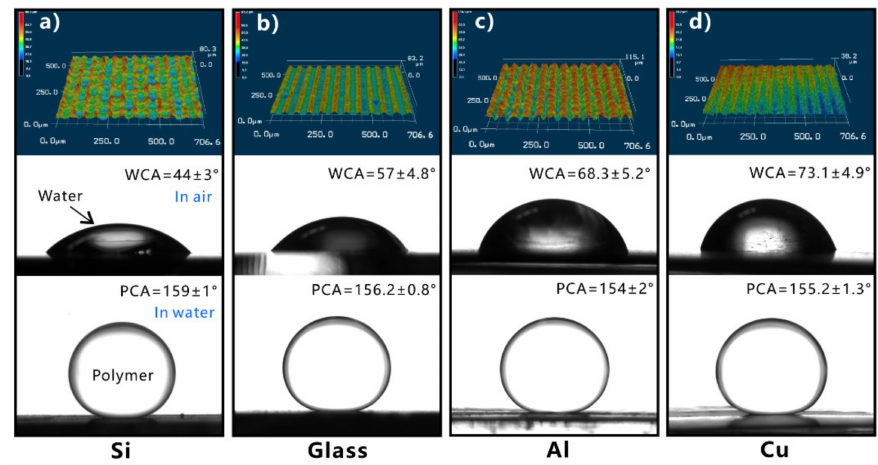
Figure 21. Underwater superpolymphobicity of the ( a ) silicon, ( b ) glass, ( c ) aluminum, and ( d ) copper surfaces after the preparation of surface microstructures. First line: Surface microstructures on the substrates. Second line: In-air water droplets on the original substrates without surface microstructures. Third line: A droplet of liquid polymer on the structured surfaces in water. Reprinted from ref.